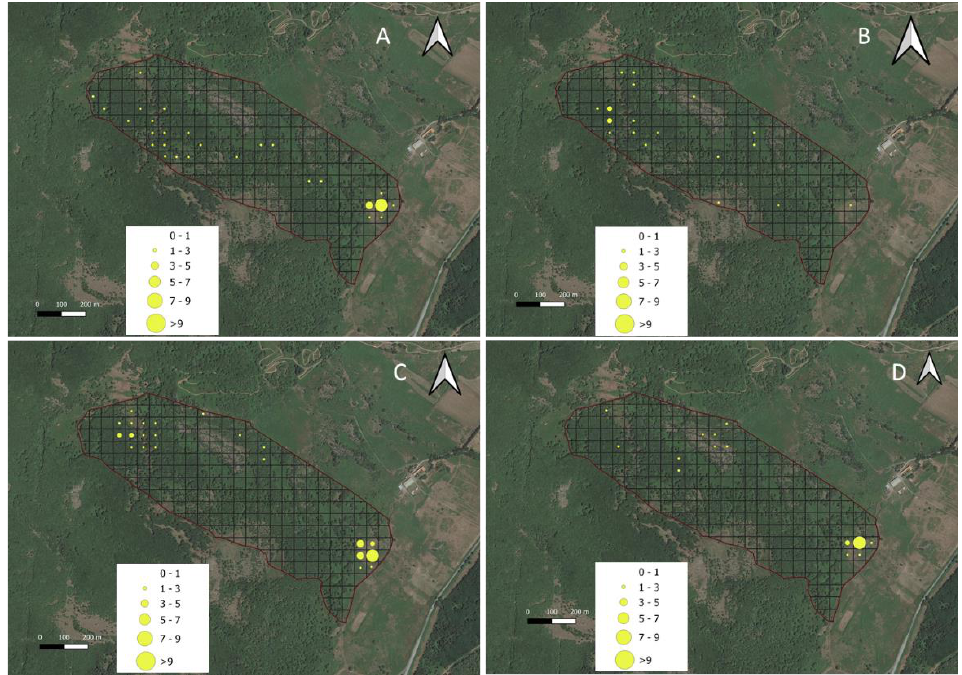
Figure 3. Spatial variation in experimental area used by Sarda cows over the winter ( A ), spring ( B ), summer ( C ) and autumn ( D ) deployment period expressed as a Livestock residence index (LRI X 100) map on a 50 m grid.